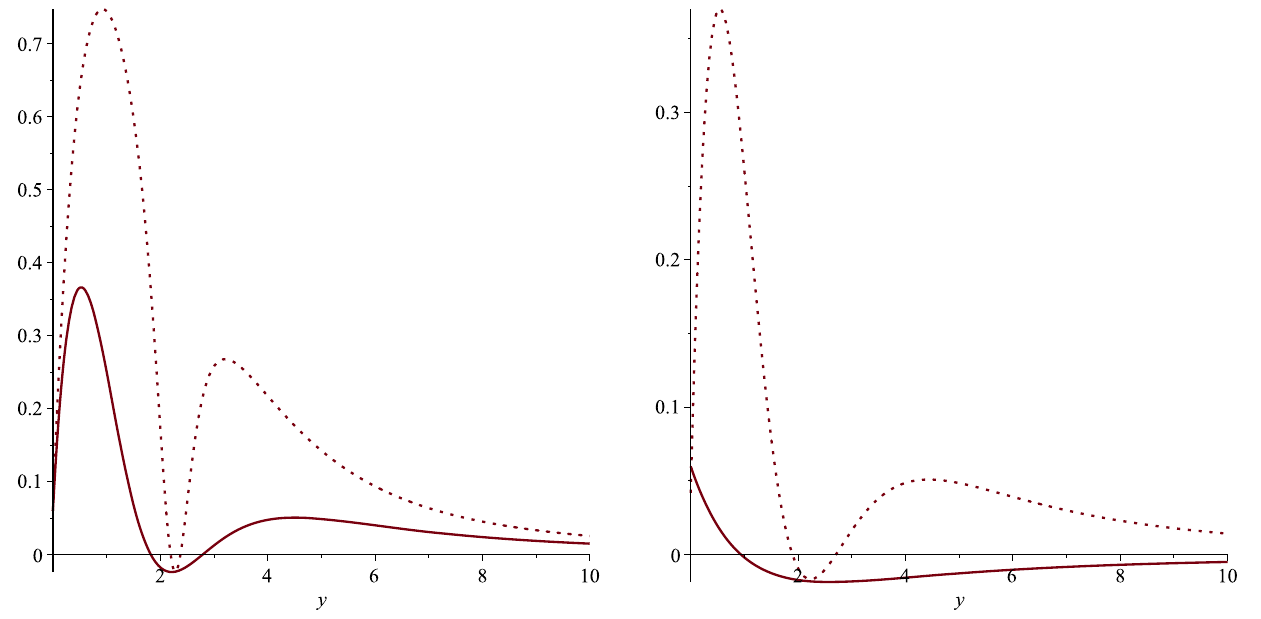
Fig. 13 Plot of the radial andtangentialpressures h 2 p r (solidline)and h 2 p ⊥ (dotted line) versus y = ( r / h ) 1 /ξ in the case ξ = 1 / 2 and μ = 0 . 7.6 . 5 . 29in[70]hasbeenusedtoexpandthelowerincompleteGamma functionin(45)wherethefirsthundredtermsintheexpansionhavebeen considered. The minima of the radial and tangential pressures denoted by y r and y ⊥ do not coincide and they are located at y r = 2 . 6038 and y ⊥ = 2 . 2335,